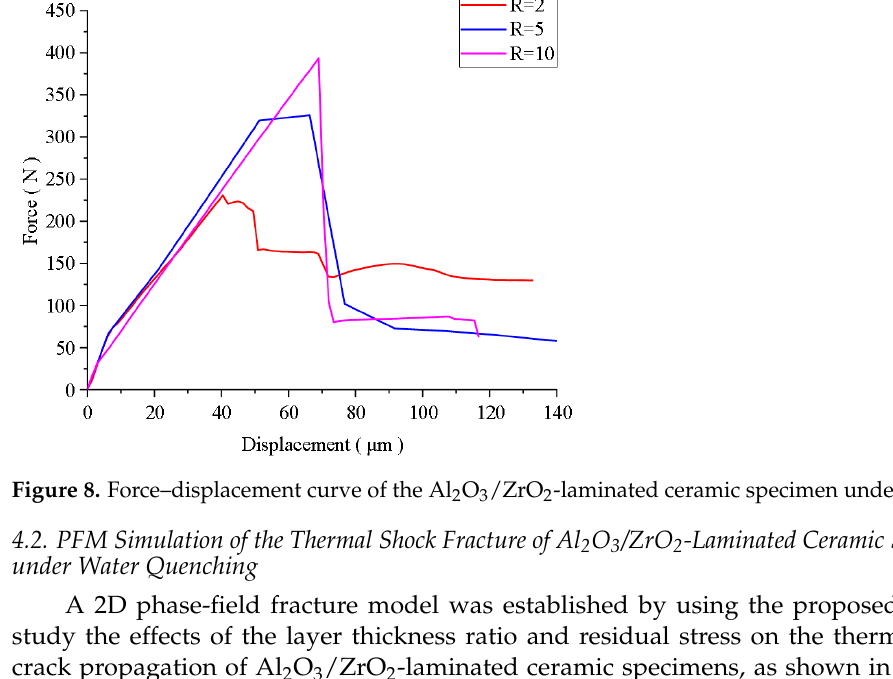
Figure 10. Curves of the ( a ) thermal expansion coefficient, α , ( b ) Young’s modulus, E , ( c ) thermal conductivity, k , and ( d ) specific heat, C p , of Al 2 O 3 /ZrO 2 -laminated ceramics versus temperature.